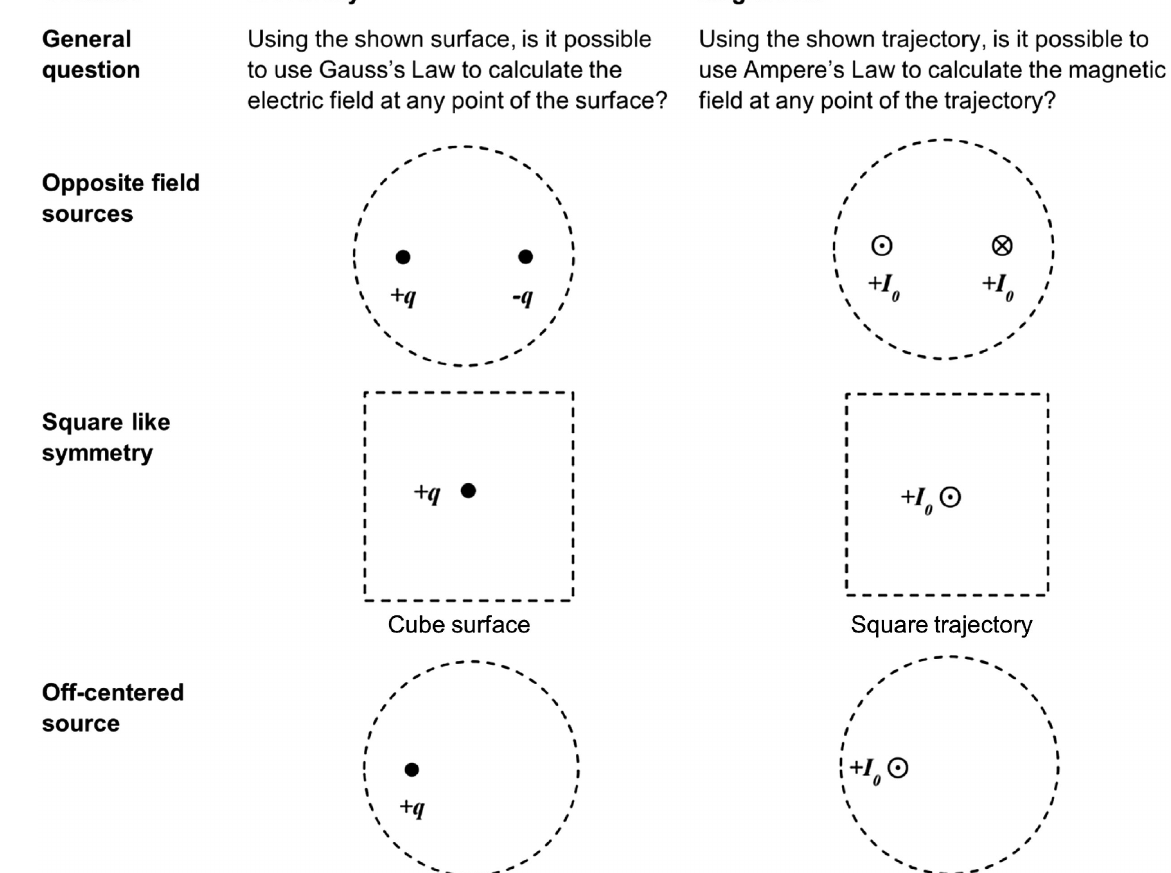
FIG. 2. Three different inverse problems where the field cannot be solved from Gauss ’ s or Ampere ’ s laws. The scenarios use parallel representations for the two